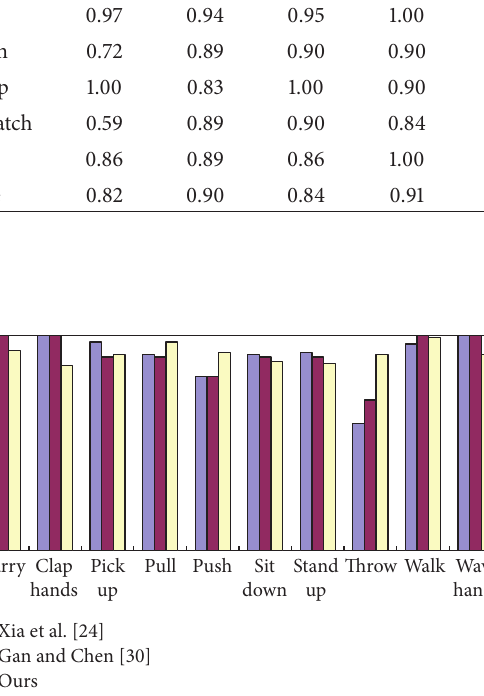
Figure 7: Results on UTKinect Action dataset.